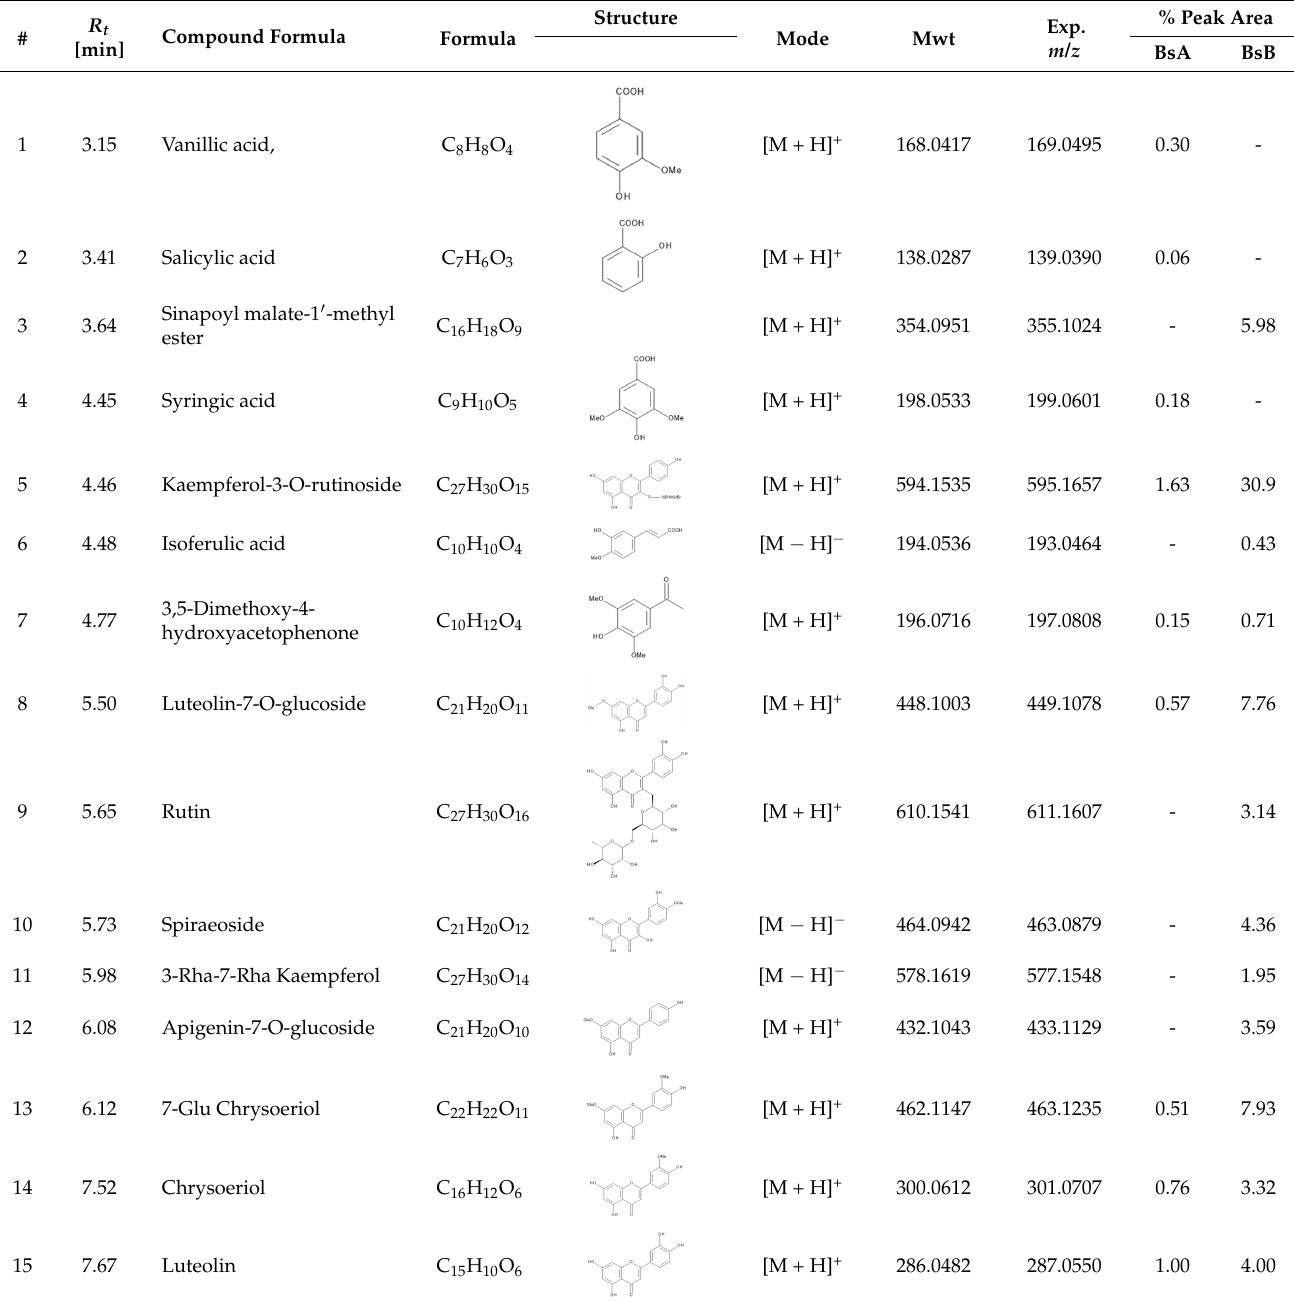
Table 4. Both extracts were screened qualitatively and quantitatively for the presence of the selected phenolic acids, flavonoids, selected terpenoids, and fatty acids. A total of 23 compounds were detected in the BsB fraction, whilst 22 compounds were found in the BsA fraction. A careful inspection of the results indicates that 11 flavonoids can be seen in the BsB fraction, which makes up 75.92% of the total composition. This high concentration level of flavonoid derivatives explains the high antioxidant activities we observed. This fraction mostly contained 7,4’-dimethoxy-3-hydroxyflavone (34.68%), kaempferol-3,7,4’- trimethyl ether (29.17%), and corymbosin (9.66%). Table 4. LC-MS data for phenolics, flavonoids, selected terpenoids and acids in detected in the BsA and BsB extracts from B. saxatilis from Jordan .